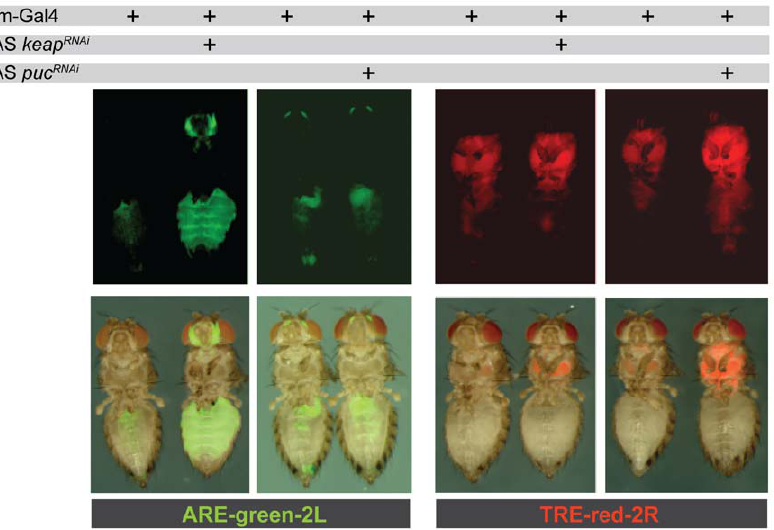
Figure 2. Transgenic ARE reporters and TRE reporters are specifically responsive to Nrf2 and JNK signaling respectively. Loss of dKeap1 function specifically activates Nrf2 activity in vivo [24]. Consequently, expressing a Keap1-specific RNAi under the control of the ubiquitously active arm-Gal4 driver activated the ARE-green reporter, but not the TRE-red reporter. Conversely, arm-Gal4 driven expression of RNAi targeting Puc, the negative regulator of JNK signaling, stimulated TRE-red reporter activity but did not affect the ARE-green reporter. The upper panels show red and green fluorescence in adult 5-day-old female flies. These fluorescence images were superimposed onto the bright-field images of the same flies, as shown in the lower panels. 15 to 20 flies were analyzed for each genotype and all showed similar results. The images shown show representative, randomly selected specimens. doi:10.1371/journal.pone.0034063.g002 PLoS ONE |